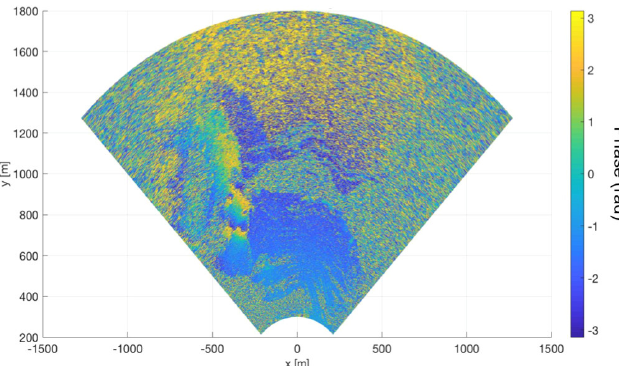
Figure 18. Radar image (without application of CS techniques) of a copper mine in South America.